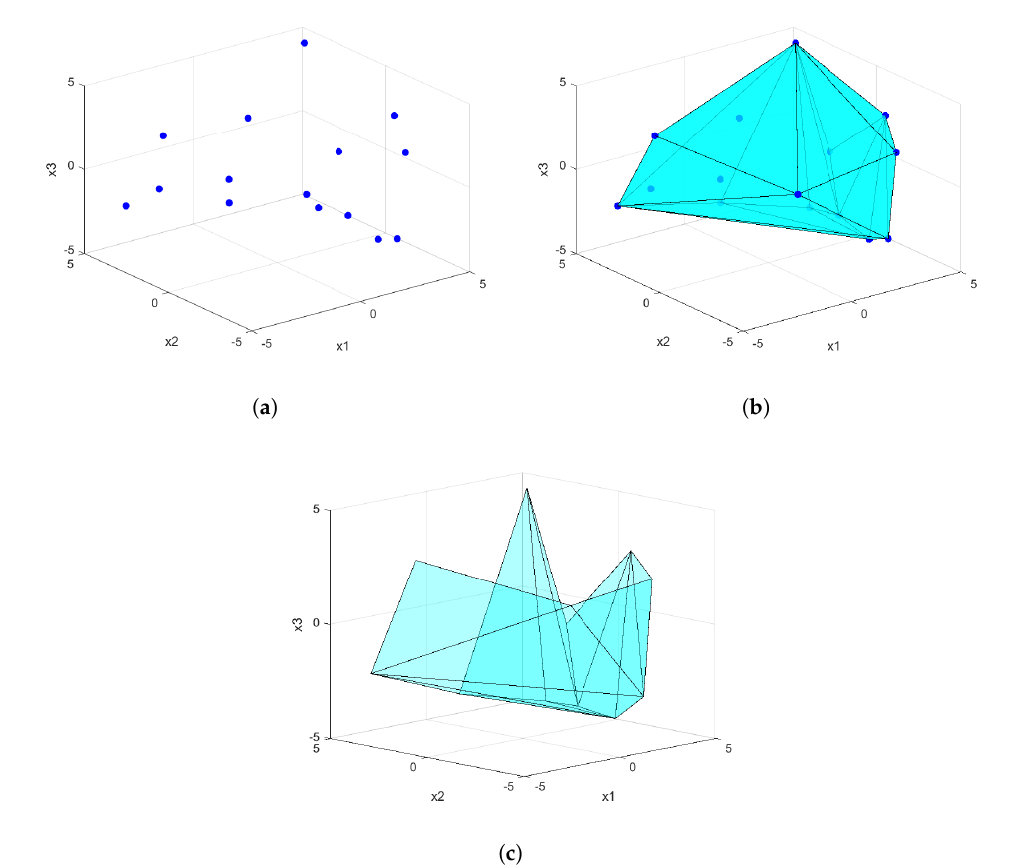
Figure 5. Constructing the convex function landscape when d = 3, N = 15. ( a ) Randomly generated points in 3D space. ( b ) Constructed convex hull. ( c ) The remaining lower hull H L after removing the upper